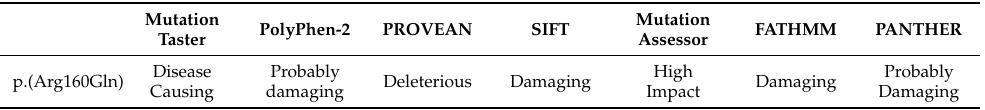
Table 2. In silico predictions of the impact of the Arg160Gln mutation on PCSK9 protein using dif ‐ ferent online tools.